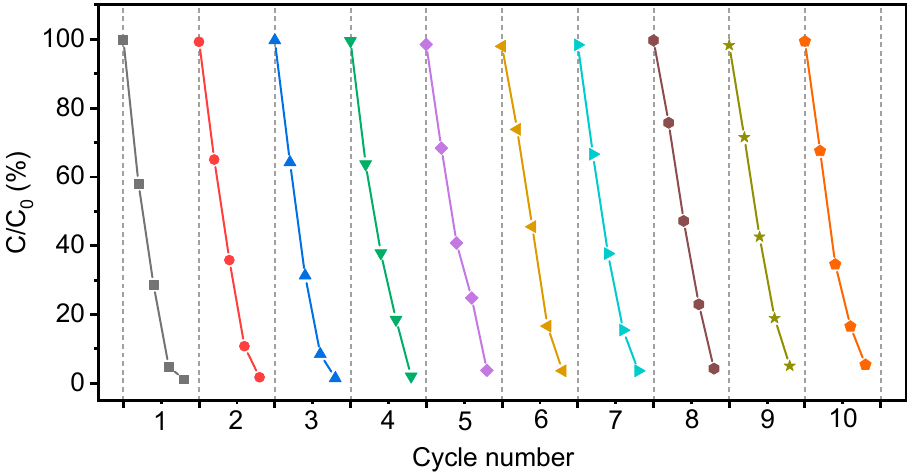
Figure 6. Recycle tests of TQDs/CC-2.5. The cycles of test increases from left to right, and each colored curve represents the number of cycles.